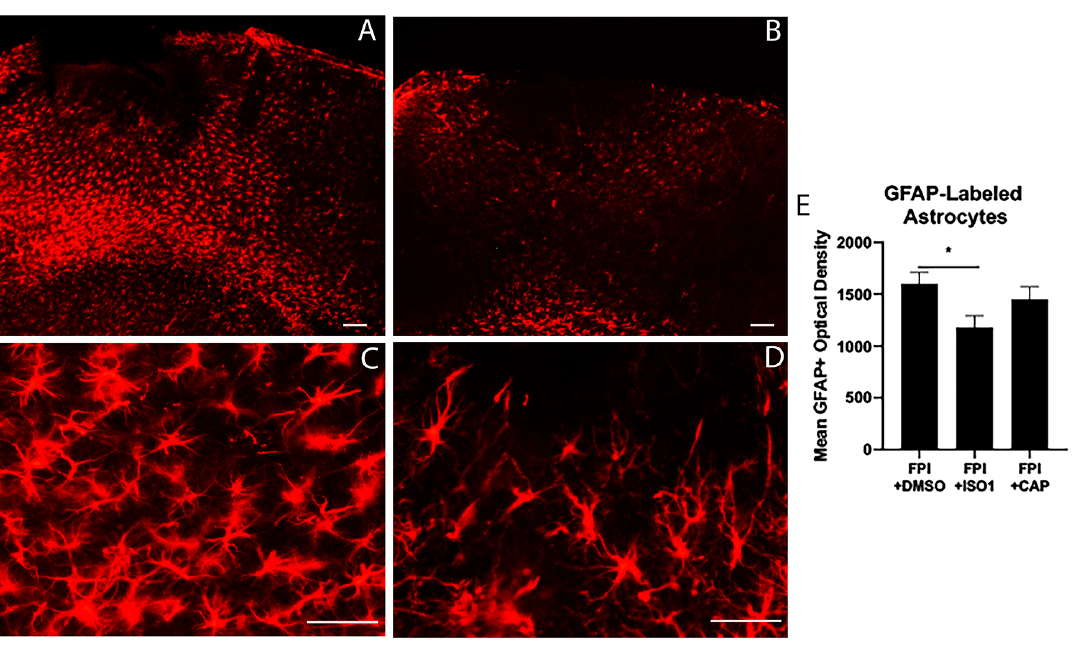
Figure 1. Antagonizing macrophage migration inhibitory factor (MIF) inhibits traumatic brain injury (TBI)-induced astrocytosis. Glial fibrillary acidic protein (GFAP)-labeling in peri-lesion cortex at 3